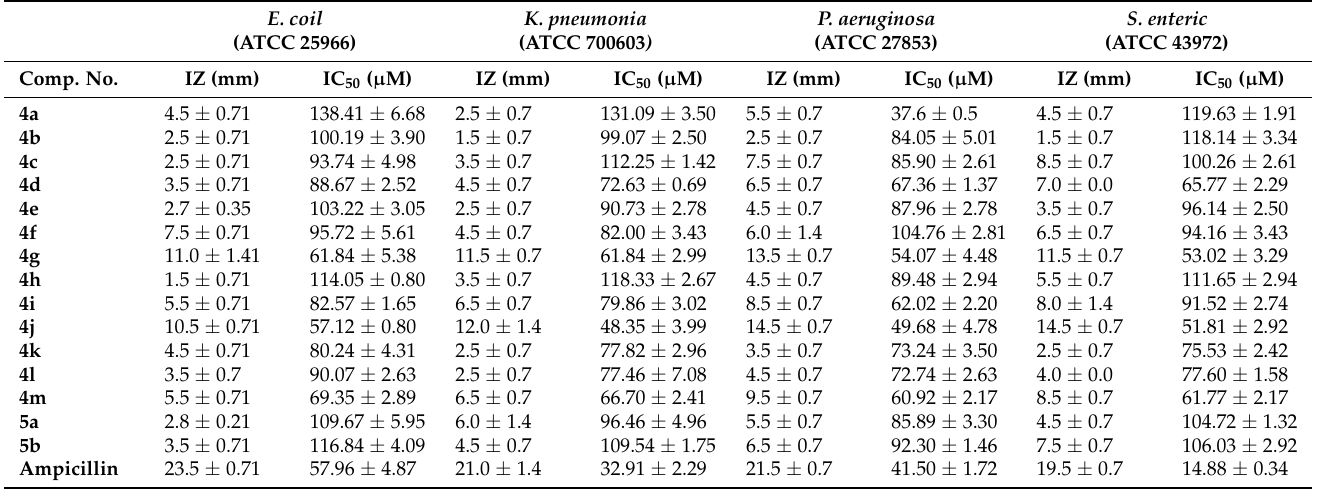
Table 3. Antibacterial evaluation for the studied compounds against some Gram-negative bacterial strains by measurement of the diameters of the inhibition zones (IZs, mm) and determination of the half-maximal inhibitory concentrations (IC 50 s, µ M). Ampicillin was used as the reference antibiotic. Results were obtained from three independent